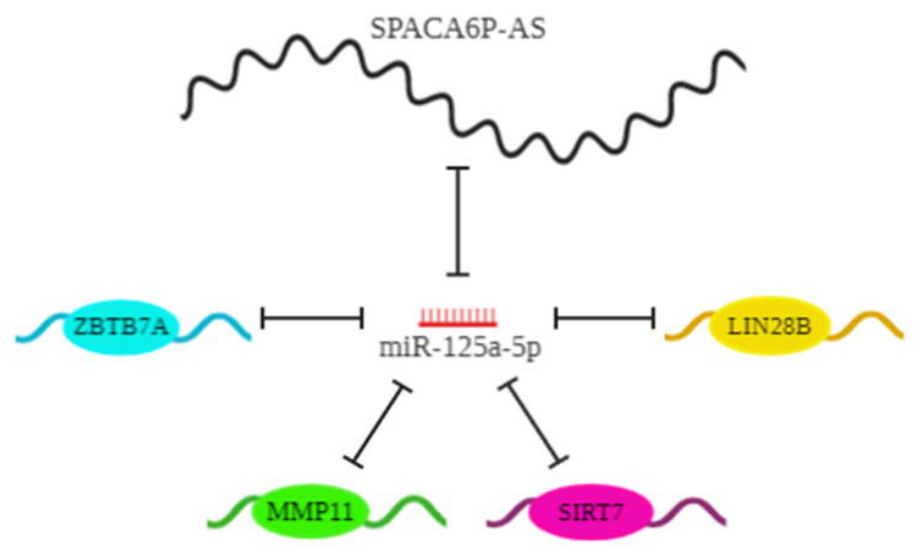
Figure 6. Interactions among SP-AS, miR-125a, and downstream target mRNAs depict a competing endogenous RNA network (ceRNET) in HCC cells. The long non-coding RNA (lncRNA) SP-AS and miR-125a regulate each other; SP-AS can interact with the miRNA, preventing its inhibitory binding to the target transcripts encoding proteins, represented by ovals; the mRNA targets can compete with one other for binding to the miRNA and titrating its availability, thus having a regulatory potential, beyond their coding power. Finally, both Zbtb7a and Lin28b proteins can transcriptionally or post-transcriptionally repress miR-125a, giving rise to a multifaceted liaison between biogenesis and regulatory role of the miRNA. Aberrant expression of any component of the circuit could derail the network, with pathological